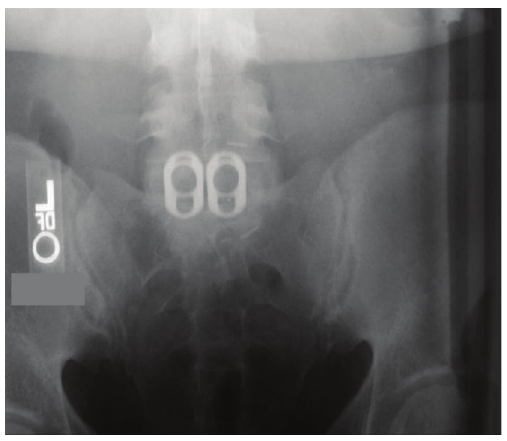
Figure 1: Standard narrow cage placement at L5-S1 level.